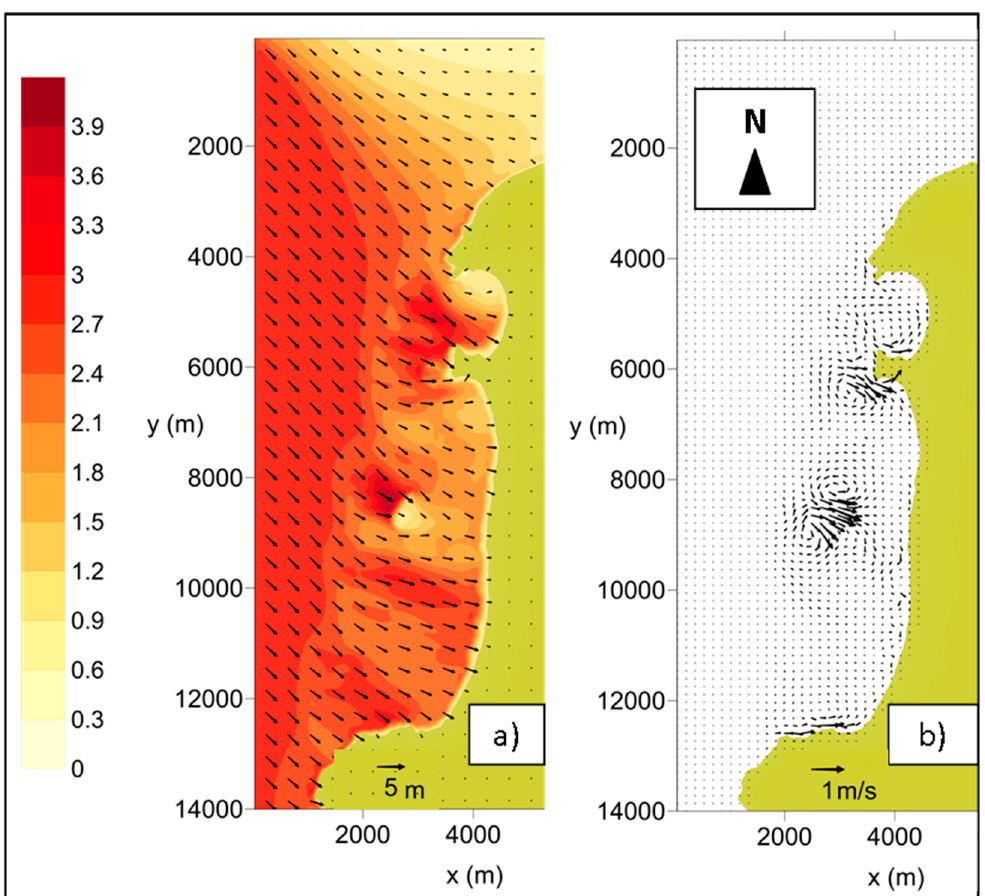
Figure 4. Example of model results for wave heights ( a ) and wave-induced currents ( b ) at the Negril coastal area. Conditions: Offshore wave height (Hrms) of 2.8 m, and period (Tp) of 8.7 s. Waves approach from the NW.